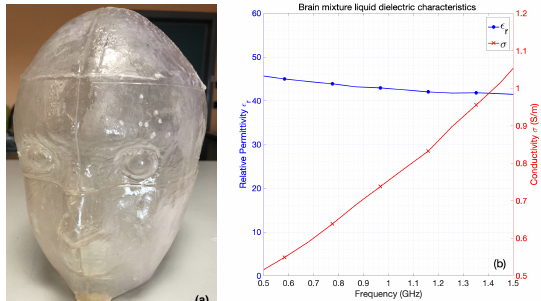
Figure 4. Anthropomorphic head phantom; ( a ) structure, and ( b ) dielectric characteristics of the liquid mixture, mimicking brain tissues as averages, which fills the